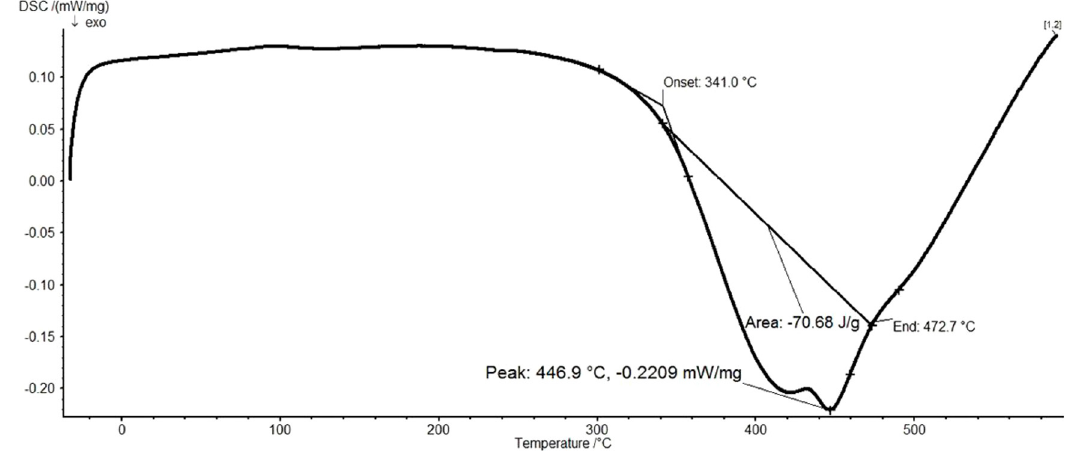
Fig. 5. DSC picture of a Ni-Ti sample showing formation of NiTi 2